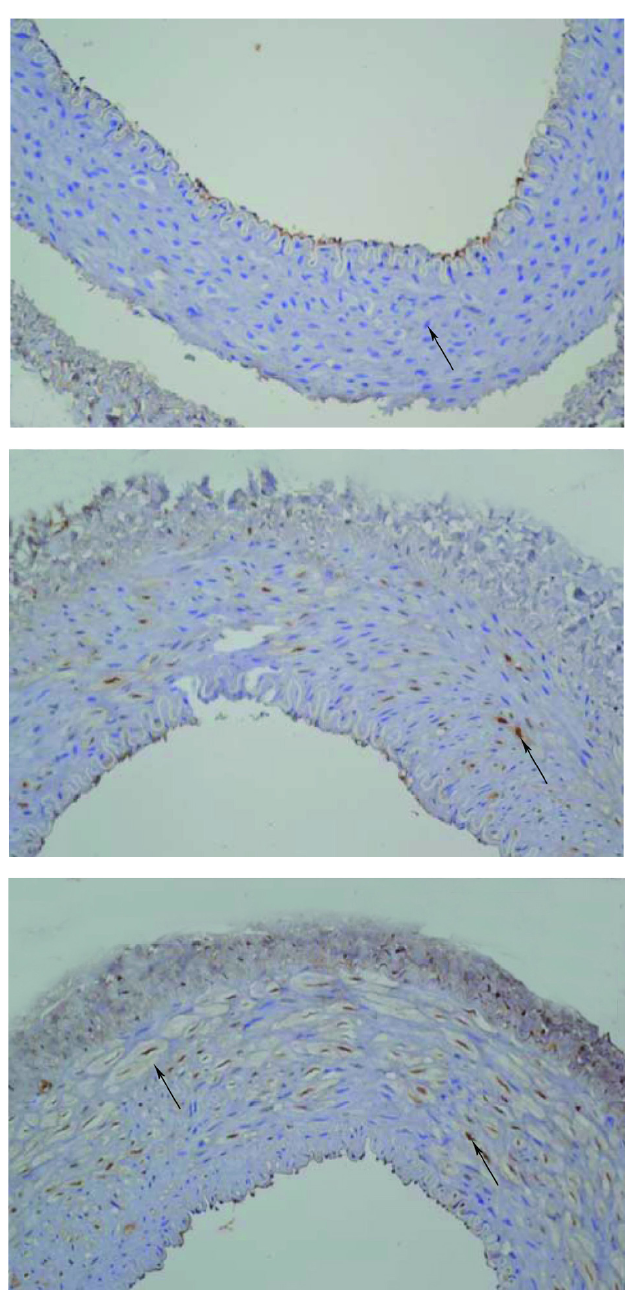
FIGURE 1 - Immunohistochemical PCNA staining (×200). Cells stained with brownish color were considered positive. (a) shows tissues from the non-injured left iliac arteries (n=10) from nesiritide group. No PCNA expression was found (arrow). (b) tissues from the injured right iliac artery tissue from the nesiritide group (n=10). Scattered PCNA expression displayed as yellow brown granules (arrow). The positive staining rate was 11.7±4.2%. (c) tissues from the injured right iliac artery from the control group (n=10) with dense PCNA expression (arrows). The positive staining rate was 36.0±11.2% ( P <0.01 compared with nesiritide